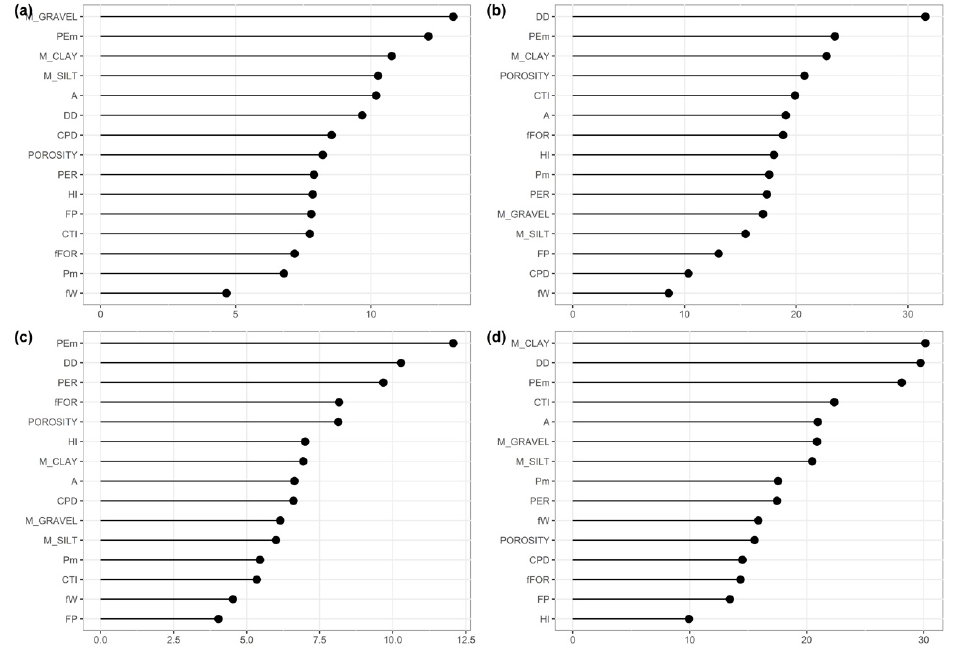
Figure 7. IncMSE scores (%) of the catchment descriptors for ( a ) X 1 , ( b ) X 2 , ( c ) X 3 , and ( d ) X 4 . Importance scores were extracted from the